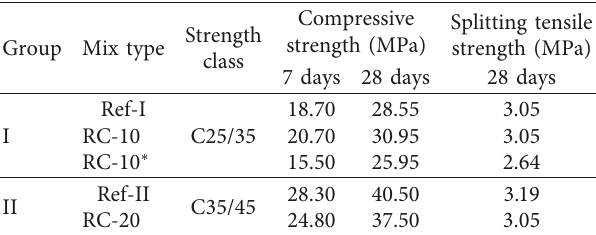
Table 5: Compressive strength and splitting tensile strength at different ages of concrete specimens.